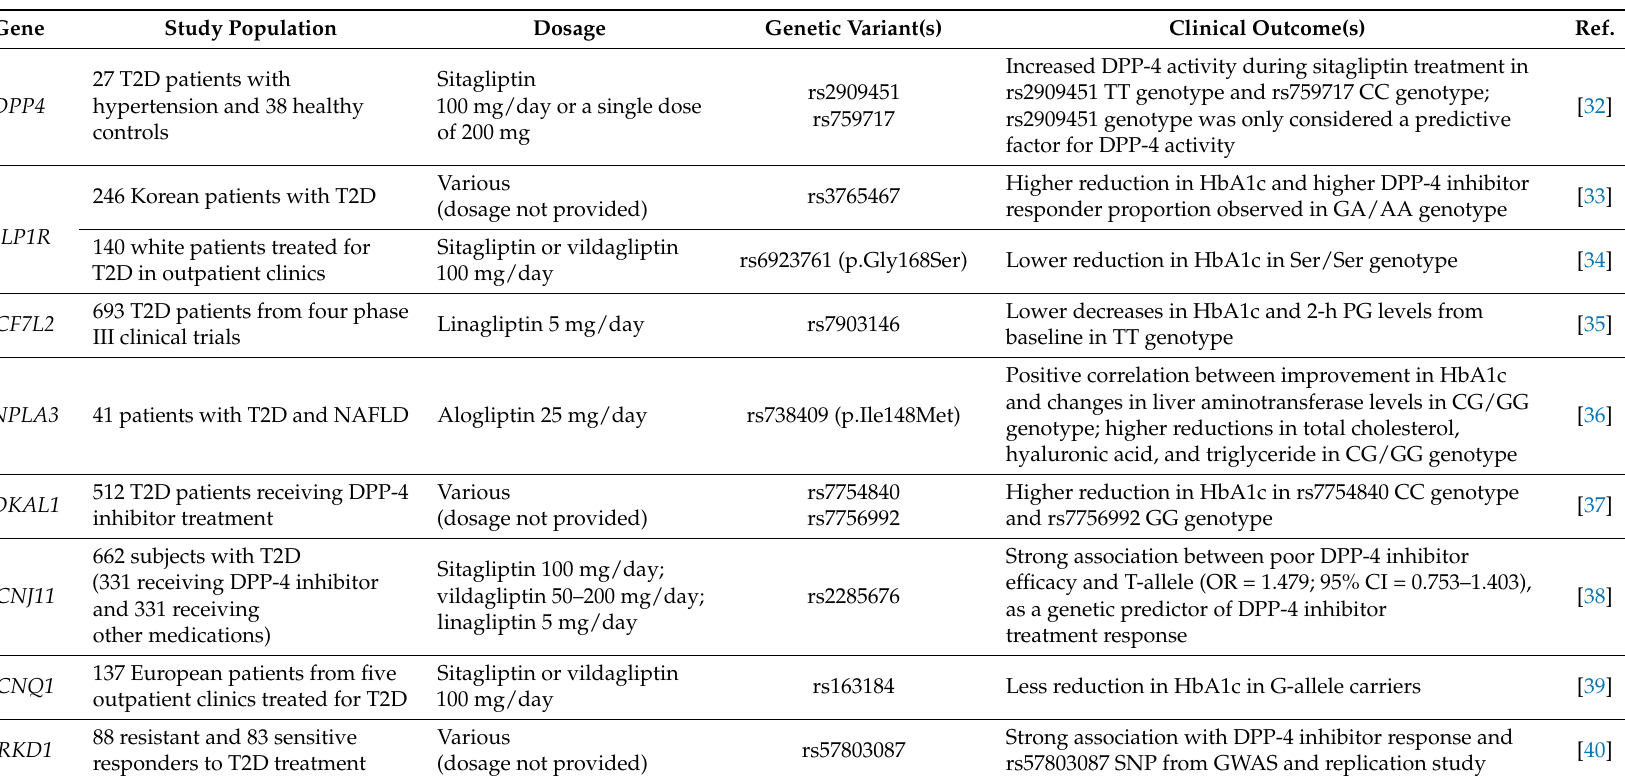
Table 2. Genes associated with responses to DPP-4